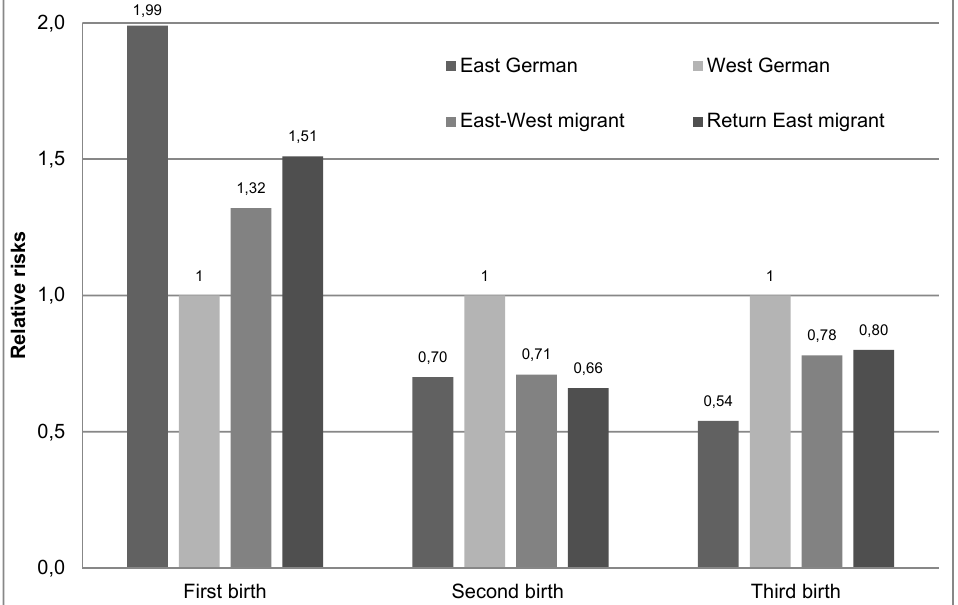
Figure 5 : Relative first, second, and third birth risks by